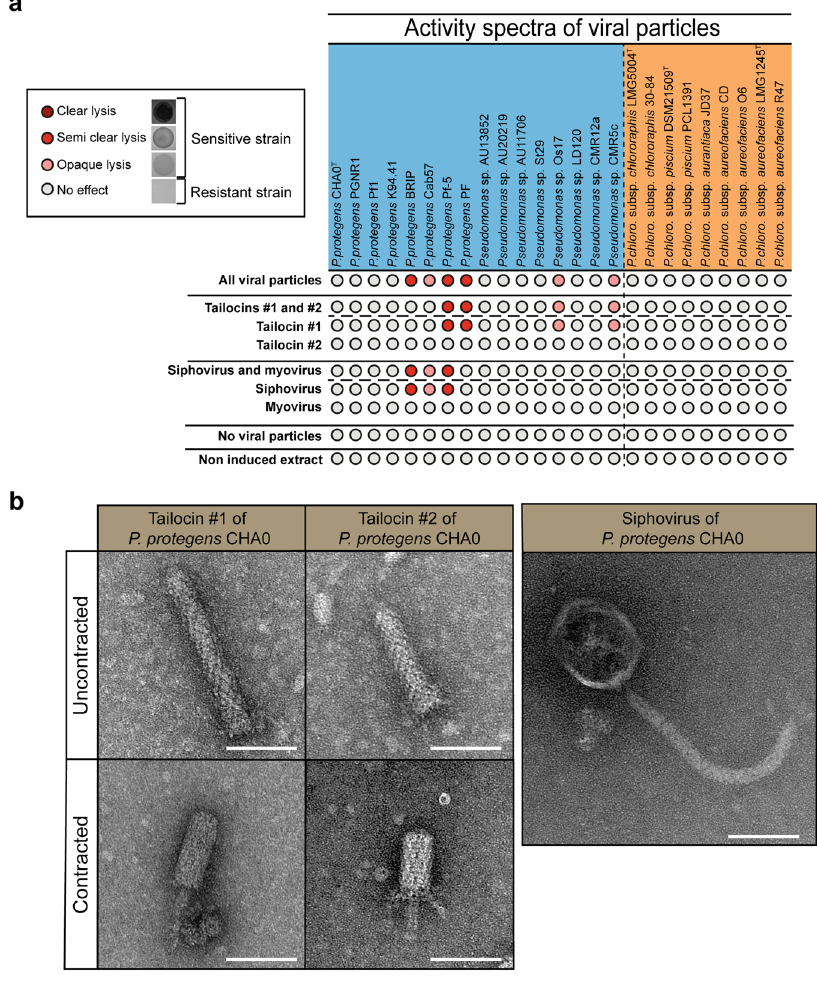
Fig. 2 The viral particles of Pseudomonas protegens CHA0 exhibit different activity spectra towards strains belonging to the Pseudomonas protegens (Pp) subgroup and the Pseudomonas chlororaphis (Pc) subgroup. a Pp (blue) and Pc (orange) strains were challenged with viral particles extracted from the following mutants that were induced or not by 3 µ g mL − 1 of mitomycin C: Tailocins #1 and #2, Δ myo Δ siph, CHA5299; Tailocin #1, Δ tail2 Δ myo Δ siph, CHA5302; Tailocin #2, Δ tail1 Δ myo Δ siph CHA5301; Siphovirus and myovirus, Δ tailcluster, CHA5285; Siphovirus, Δ tailcluster Δ myo CHA5289; Myovirus, Δ tailcluster Δ siph CHA5292 (Supplementary Table 2). Serial dilutions of the viral particles were performed and used to challenge all Pseudomonas strains. The results are available in the Supplementary Data 1. Tested Pseudomonas strains are organized in a phylogenetic manner as in Fig. 1. b Electron microscopy photographs of viral particles produced by P. protegens CHA0. Tailocin #1 and #2 are shown either in the non-contracted or contracted forms. The siphovirus possesses a characteristic long, fl exible and non-contractile tail. The myovirus of CHA0 was not detected upon the tested induction conditions. Individual viral particles were prepared from the above described CHA0 derivatives. The scale bar corresponds to 60